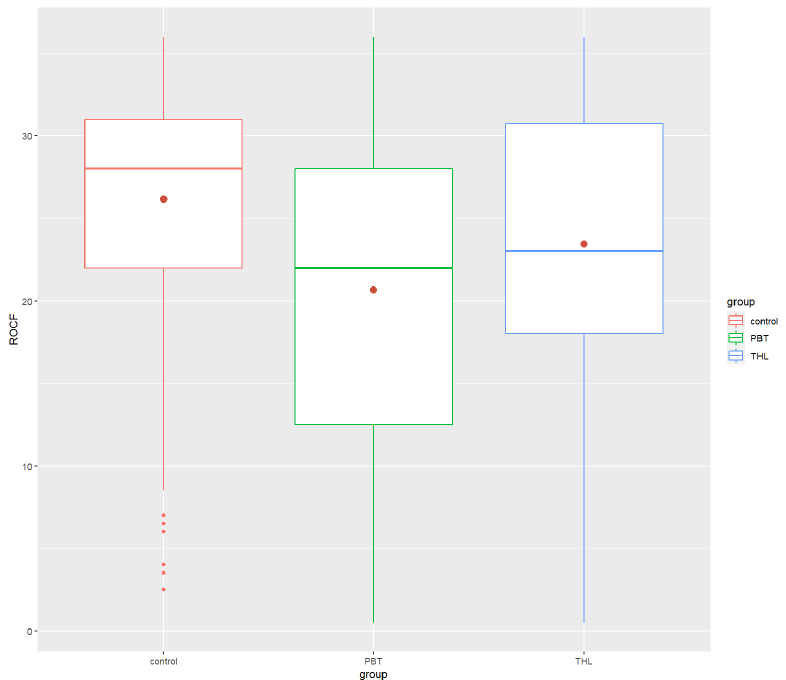
Figure 4. Boxplots of ROCF for the healthy control group and the diagnosis groups. Control—healthy control group, PBT—pediatric brain tumor survivors, THL—hematopoietic and lymphoid tissues tumor survivors. COWAT—Controlled Oral Word Association Task. ROCF—the Rey–Osterrieth Complex Figure. Red dot—mean test score for each group. Cancers 2022 , 14 ,